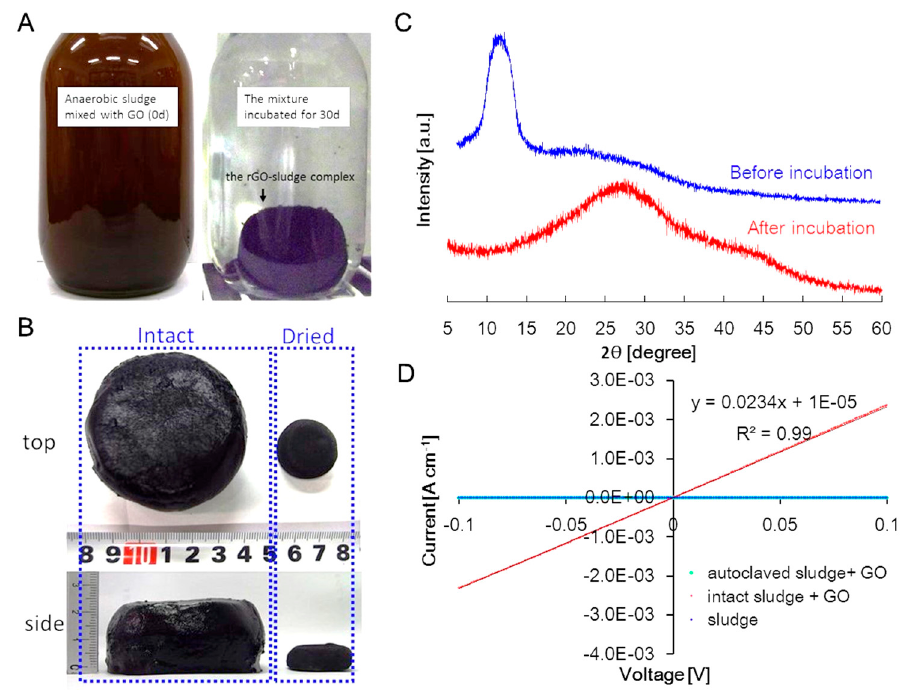
Figure 1. Graphene oxide (GO) and anaerobic sludge mixture changes, and the formation of a hydrogel complex of reduced GO and sludge. ( A ) GO reduction in the anaerobic sludge; ( B ) Changes in volume of the rGO complex before and after drying; ( C ) XRD patterns of GO and the rGO complex before and after incubation; ( D ) Conductivity of the autoclaved sludge with GO, the intact sludge with GO, and the intact sludge without GO.